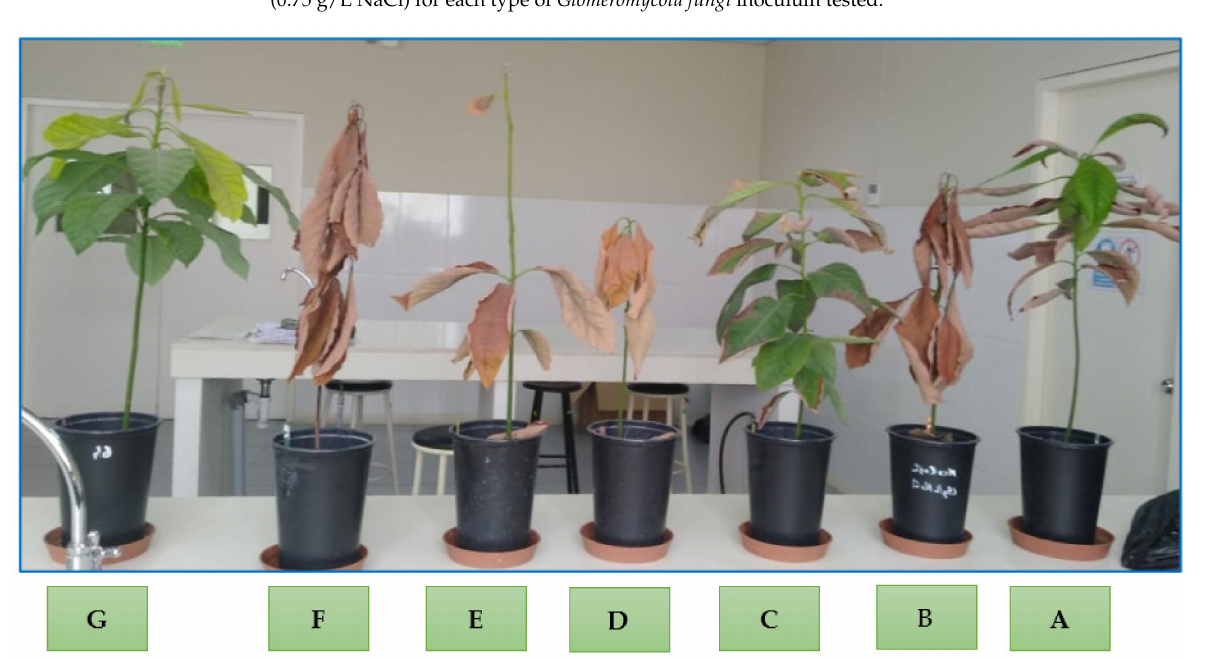
Figure 6. Seedlings of Persea americana var. Zutano according to the following treatments: ( A ) GWI + 0.75 g/L NaCl, ( B ) GWI + 1.5 g/L NaCl, ( C ) GFI+ 0.75 g/L NaCl, ( D ) GFI + 1.5 g/L NaCl, ( E ) without mycorrhizae + 0.75 g/L NaCl, ( F ) without mycorrhizae + 1.5 gLl NaCl, ( G ) without mycorrhizae/without